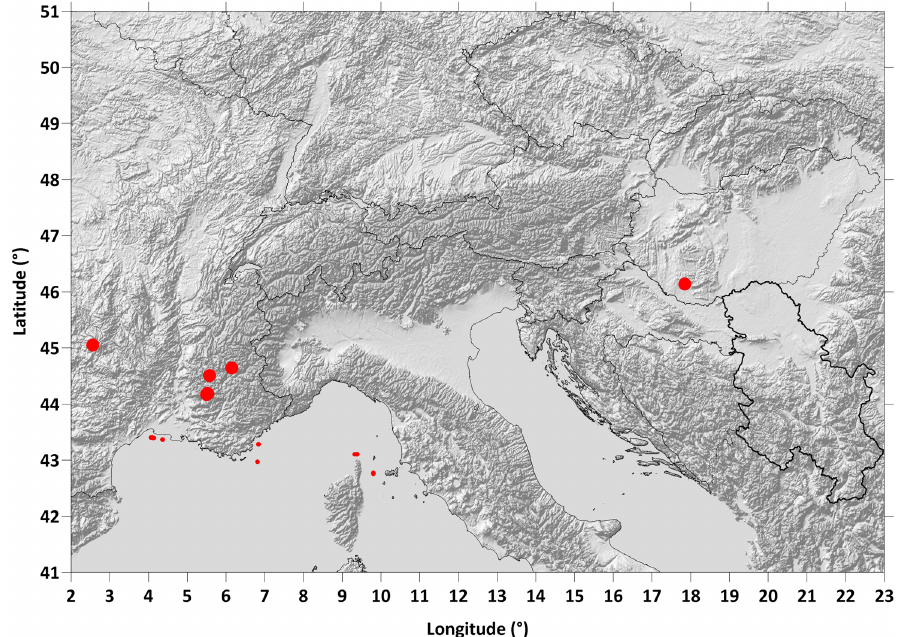
Figure 18. Position of excluded points (approx. 350 points in total) based on interpolation residuals higher than ± 10mGal. Almost all excluded points belong to marine data, and very few points lie on land (enlarged points for clarity). The shaded relief in the background shows topography to distinguish land and offshore areas from each